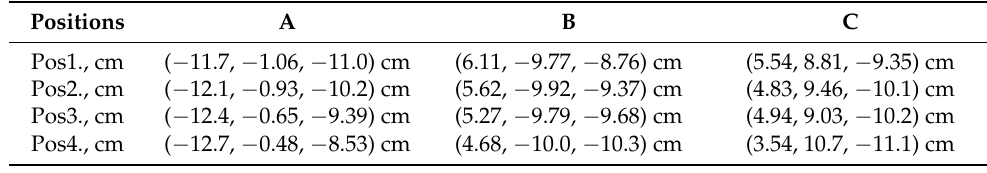
Table 5. A, B and C coordinates computed from the four positions.